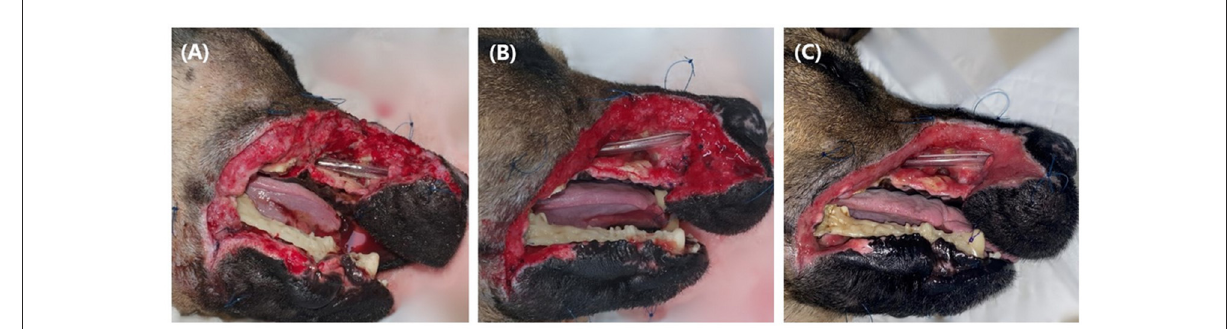
FIGURE3 Until healthy granulation tissue filled the defect, the wound was managed wet-dry for 15 days. Two days after open management (A) , 5 days after open management (B) , 15 days after open management (C) . Fresh granulation tissue started to form at some parts of the defect at 5 days, and at 15 days after open management, the wound was fully covered with granulation tissue. Note the endotracheal tube placed through the open nasal cavity (arrow), and loose sutures (arrowhead) around the defect for tie over bandage.